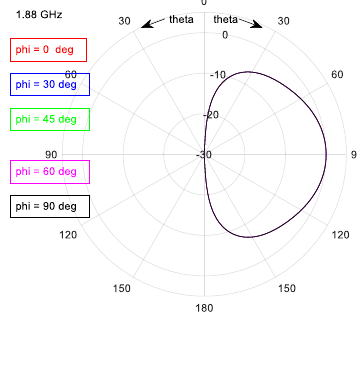
Figure 18. The patterns of the 6-ring-loaded MBA at middle-frequency points of four bands with VSWR ≤ 2 in Table 1.